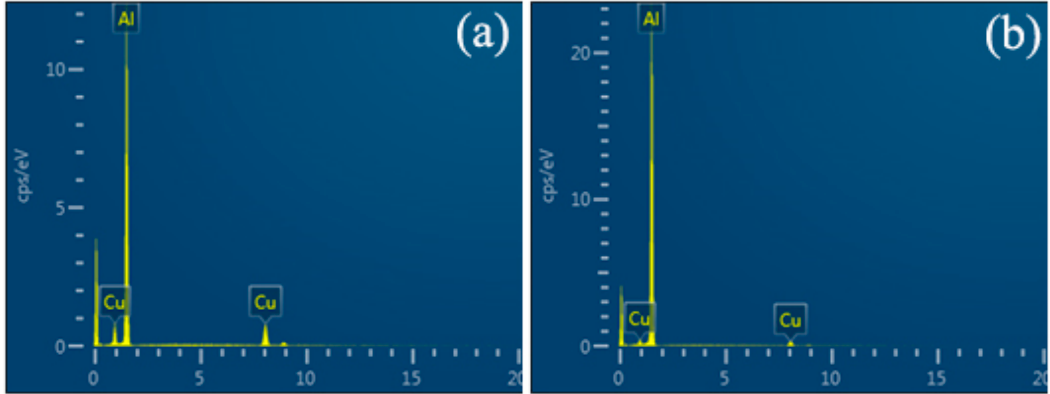
microstructures.